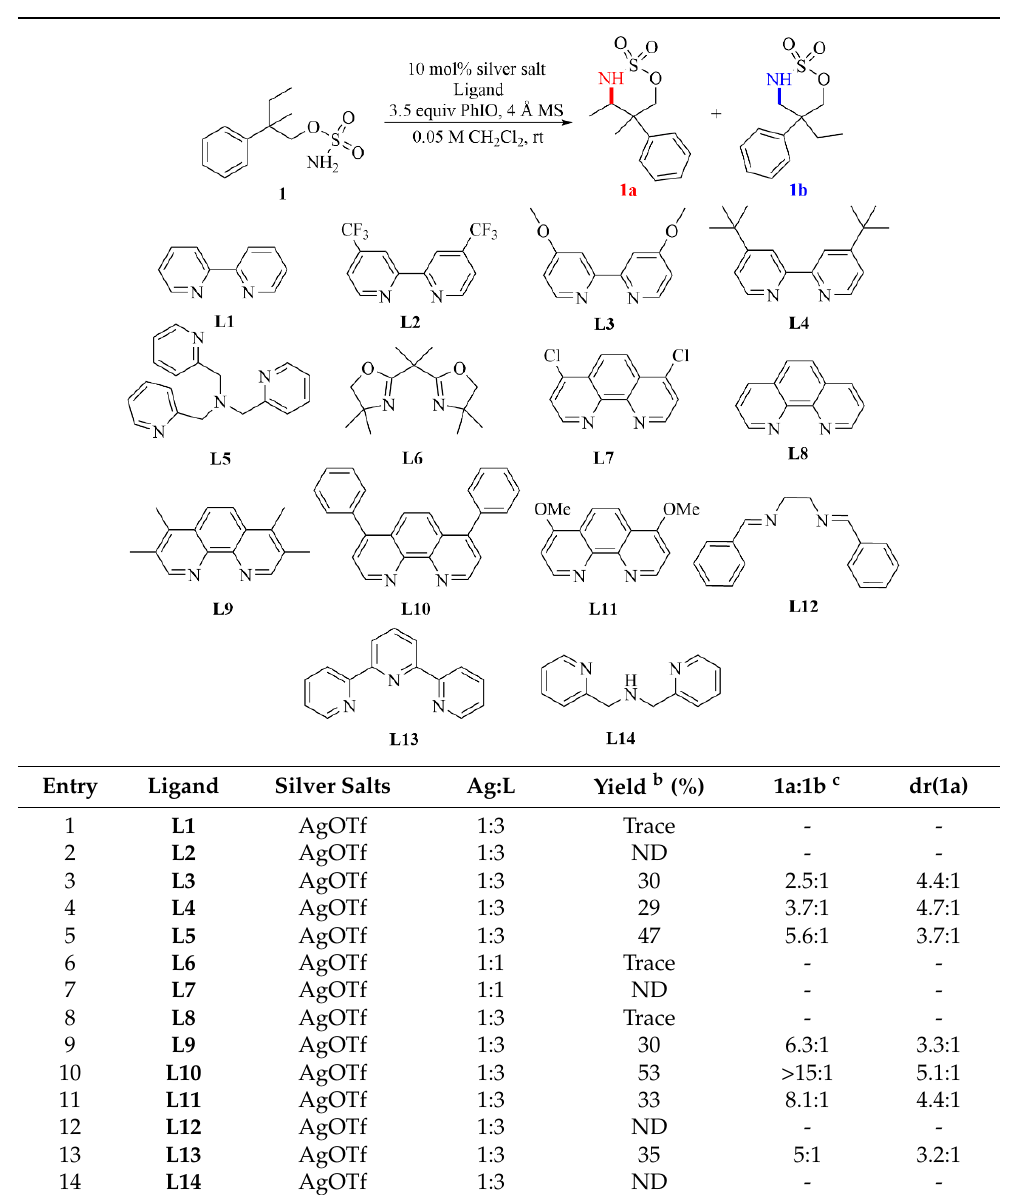
Table 1. Optimization of Ag/ligand a .